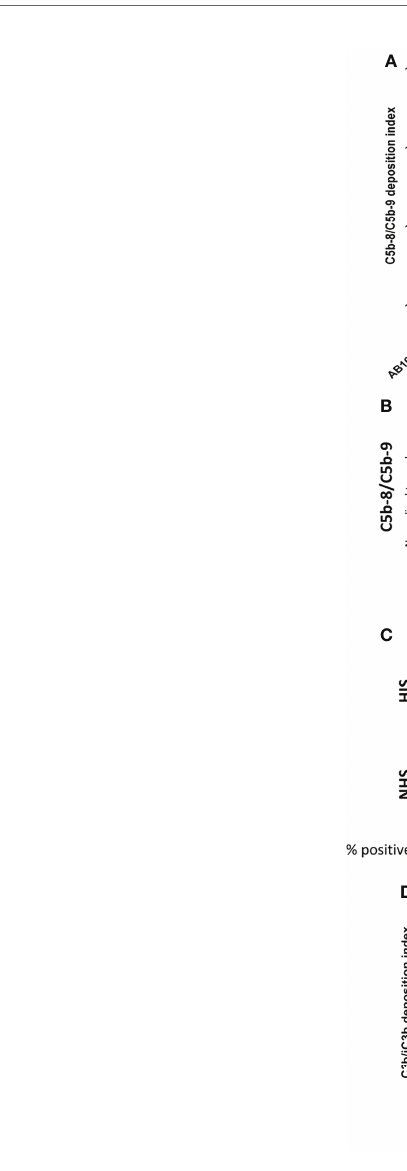
FIGURE 5 | Membrane attack complex (C5b-8/C5b-9) on the surface of clinical A. baumannii isolates. 10 6 CFU of bacteria was incubated with either 25% normal human sera or 25% heat-inactivated human sera, followed by incubation with the mouse monoclonal antibody aE11 (Abcam) that recognizes a neo-epitope on polymeric C9, and detected using an anti-mouse IgG conjugated to allophycocyanin (APC) (Jackson Immunoresearch). (A) Bar graph showing the C5b-8/C5b-9 deposition index (% positive * Median fl uorescent intensity of bacteria staining positive for C5b-8/C5b-9 deposition). (B) Representative histograms showing the deposition of C5b-8/C5b-9 on 1x10 6 CFU of three A. baumannii isolates. Each graph shows a grey histogram that represents bacteria labelled with primary and secondary antibody only, black-dotted line represents bacteria incubated with heat-inactivated human sera and black solid line represent bacteria incubated with normal human sera. (C) Confocal imaging showing C5b-8/C5b-9 deposition on a subset of A. baumannii clinical isolates following incubation with heat-inactivated sera (top panel) or normal sera (bottom panel). Blue represent DAPI stained bacteria and green shows bacteria positive for MAC deposition. Figures below each panel represent the percentage of bacterial cells in each panel showing atleast some green fl uorescent staining representing MAC deposition. A scale bar equivalent to 10 µm is indicated by a white line in all images. (D) Correlation between C5b-8/C5b-9 deposition index and C3b/iC3b deposition on the nine clinical A. baumannii isolates. Bars represent mean values for each strain and the error bars indicate standard deviations (SDs) (n = 5). T-test was used for statistical analysis *: p-value < 0.05, ***: p-value < 0.001, ns: p-value > 0.05. Pooled data from two independent experiments is